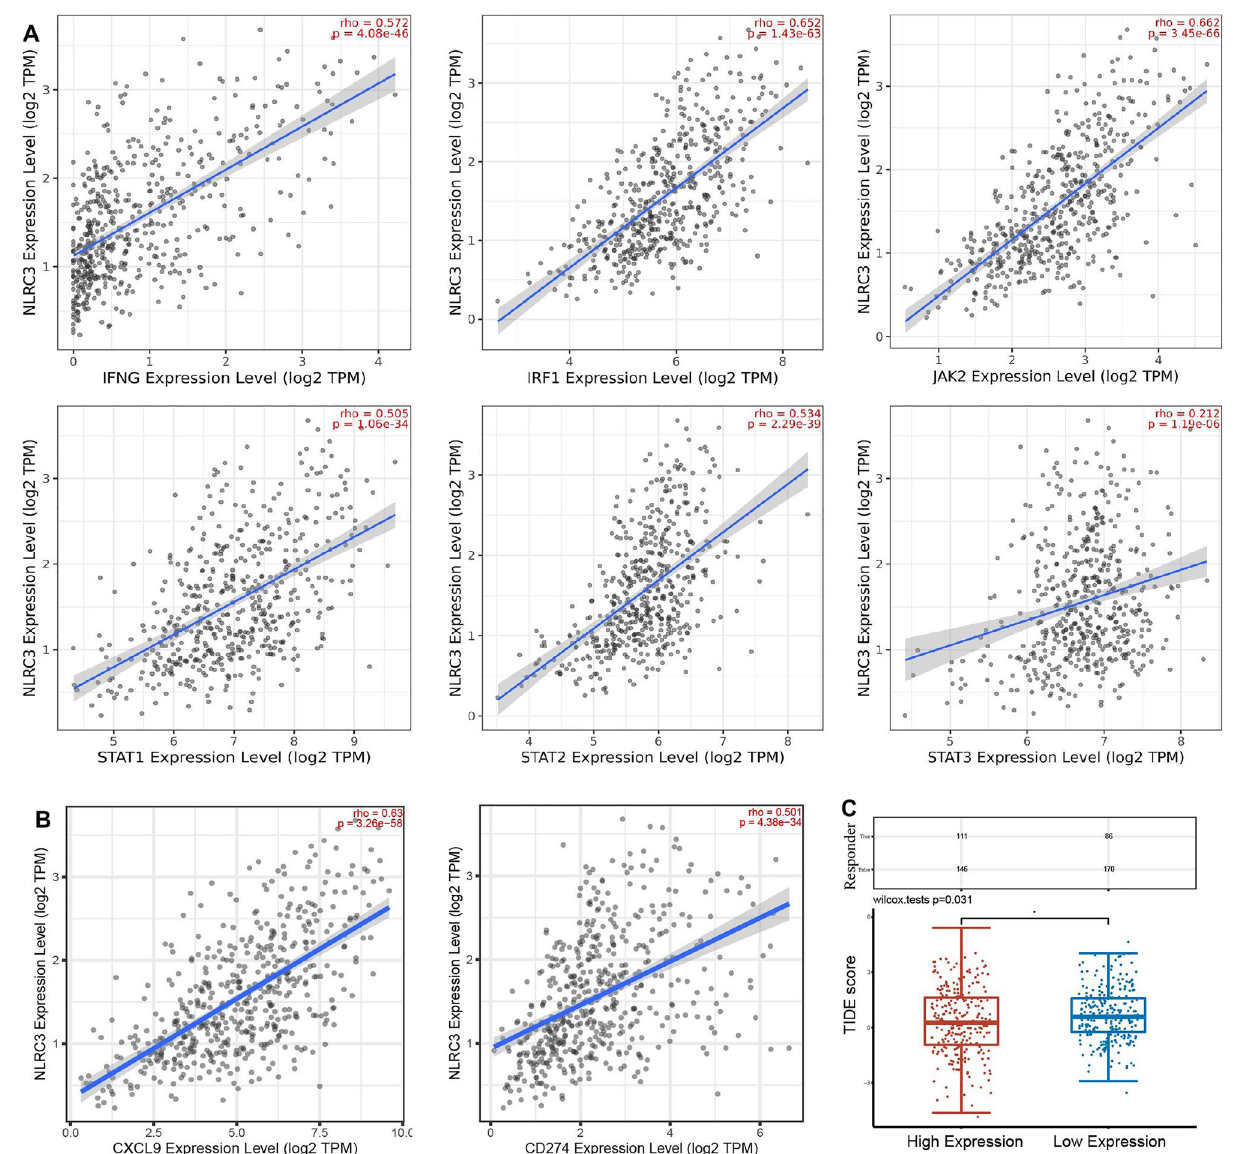
Figure 7. Patients with LUAD with high NLRC3 expression may benefit from immune checkpoint blockade (ICB) treatment. ( A ) Correlations between NLRC3 and six downstream interferon-γ signaling molecules using the TIMER2.0 database. ( B ) Spearman’s coefficient for the correlation between NLRC3 and CXCL9 / CD274 using the TIMER2.0 database. ( C ) Differential ICB responses in patients with LUAD grouped according to the median NLRC3 expression level. Analysis was performed using the software R version 4.0.3. * P <